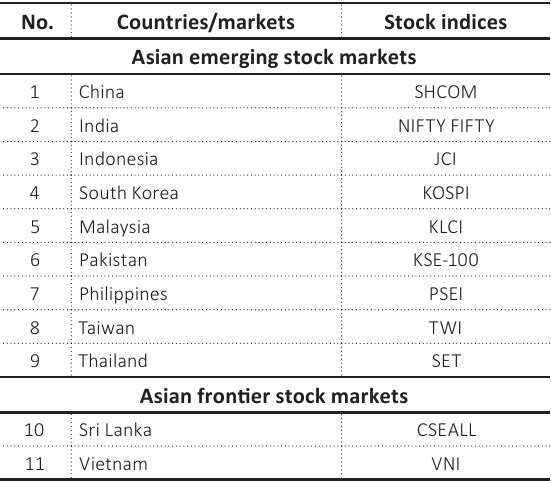
Table 1. Classification of stock